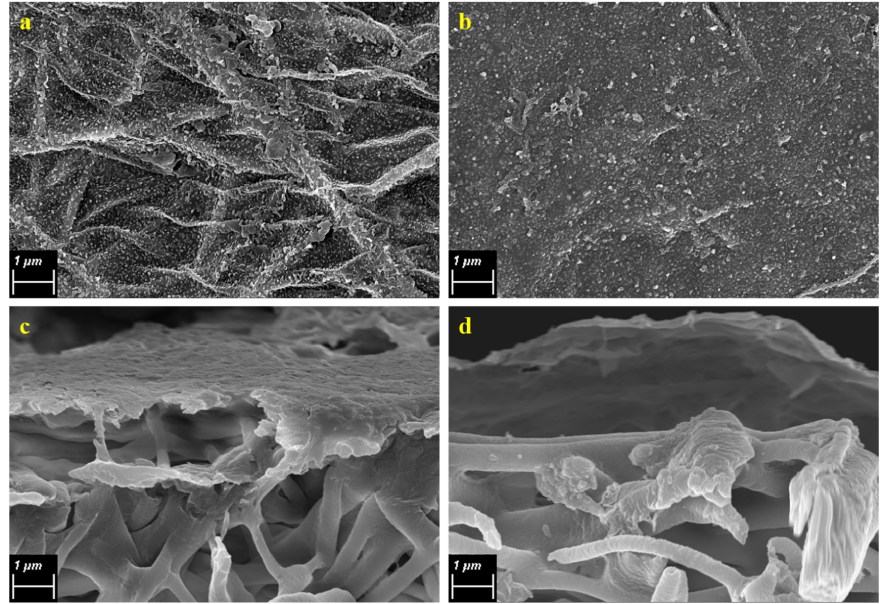
Figure 5. The ( a,b ) surface morphology and ( c,d ) cross-section morphology of the control TFC and the PVDF-LbL TFC membrane,